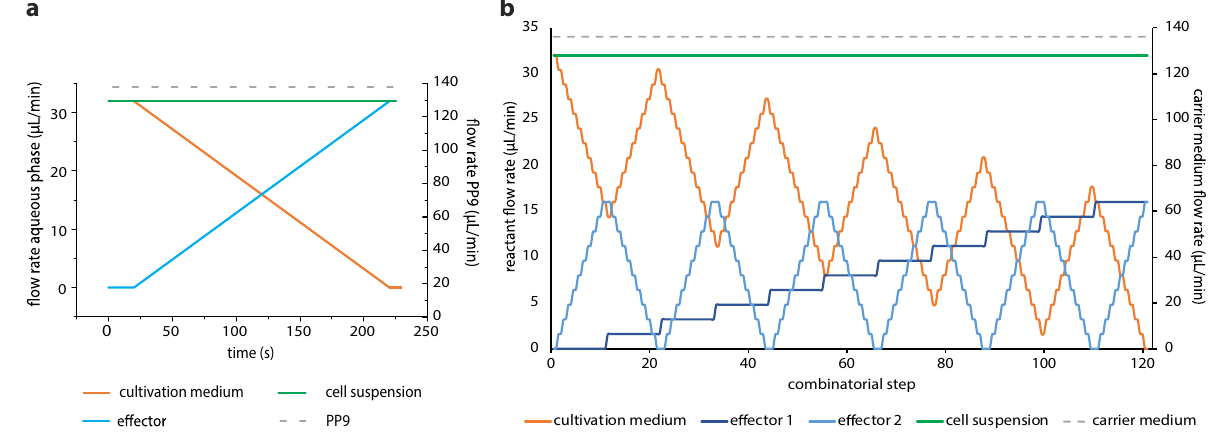
Figure 2. Syringe pump control program for the generation of 1D and 2D gradients. (a) Highly resolved dose response screening for single substances (1D screening). The base cultivation medium was continuously substituted over time by the effector-spiked medium and (b) two-dimensional concentration spaces in 11 combinatorial steps, resulting in 121 concentration combinations (2D